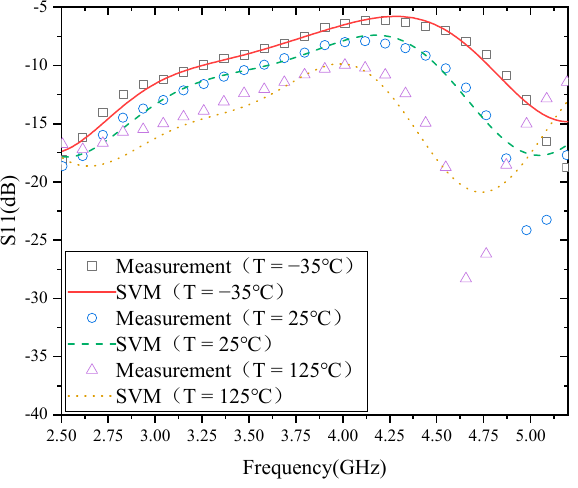
Figure 4. Modeling results of S11.